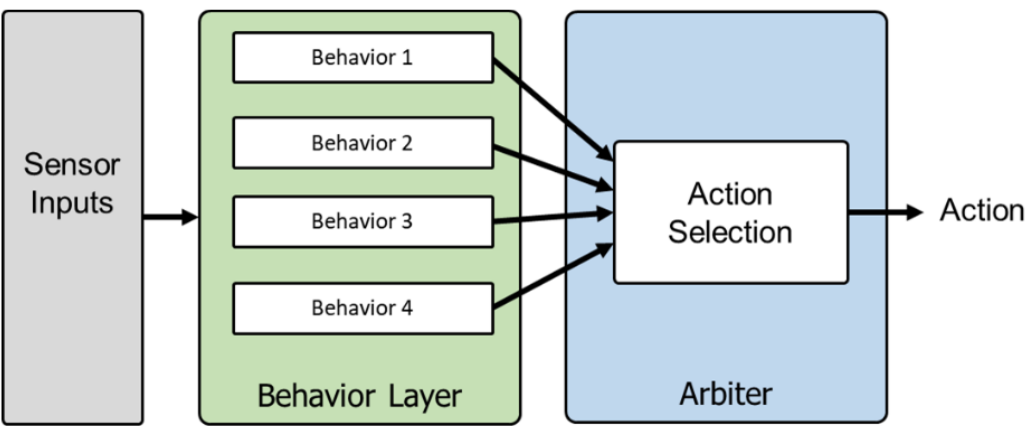
Figure 4. A generalized behavioral-based robotics architecture.